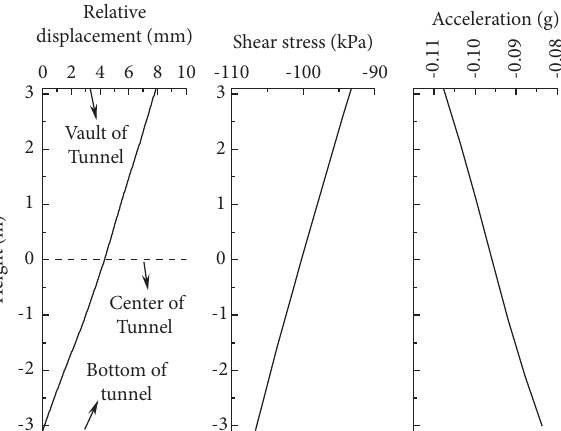
Figure 7: Seismic response of free-field corresponding to the height of the